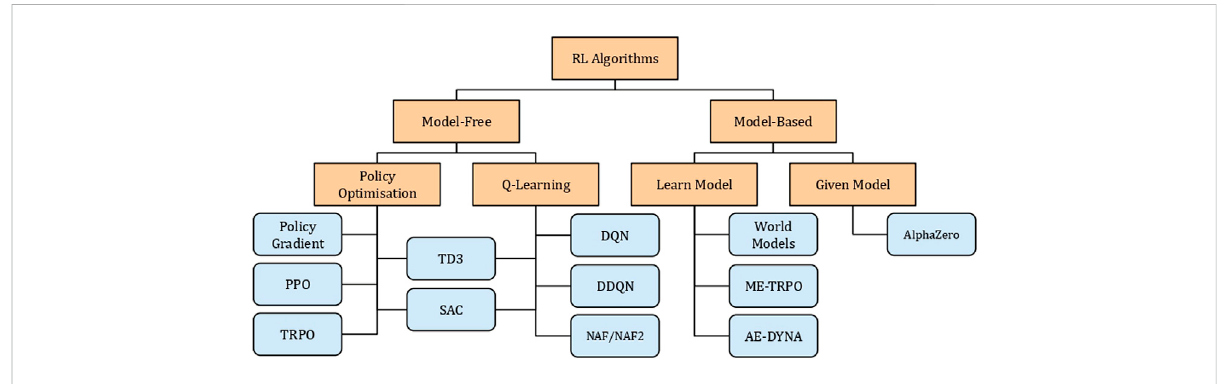
FIGURE 2 A non-exhaustive taxonomy of RL